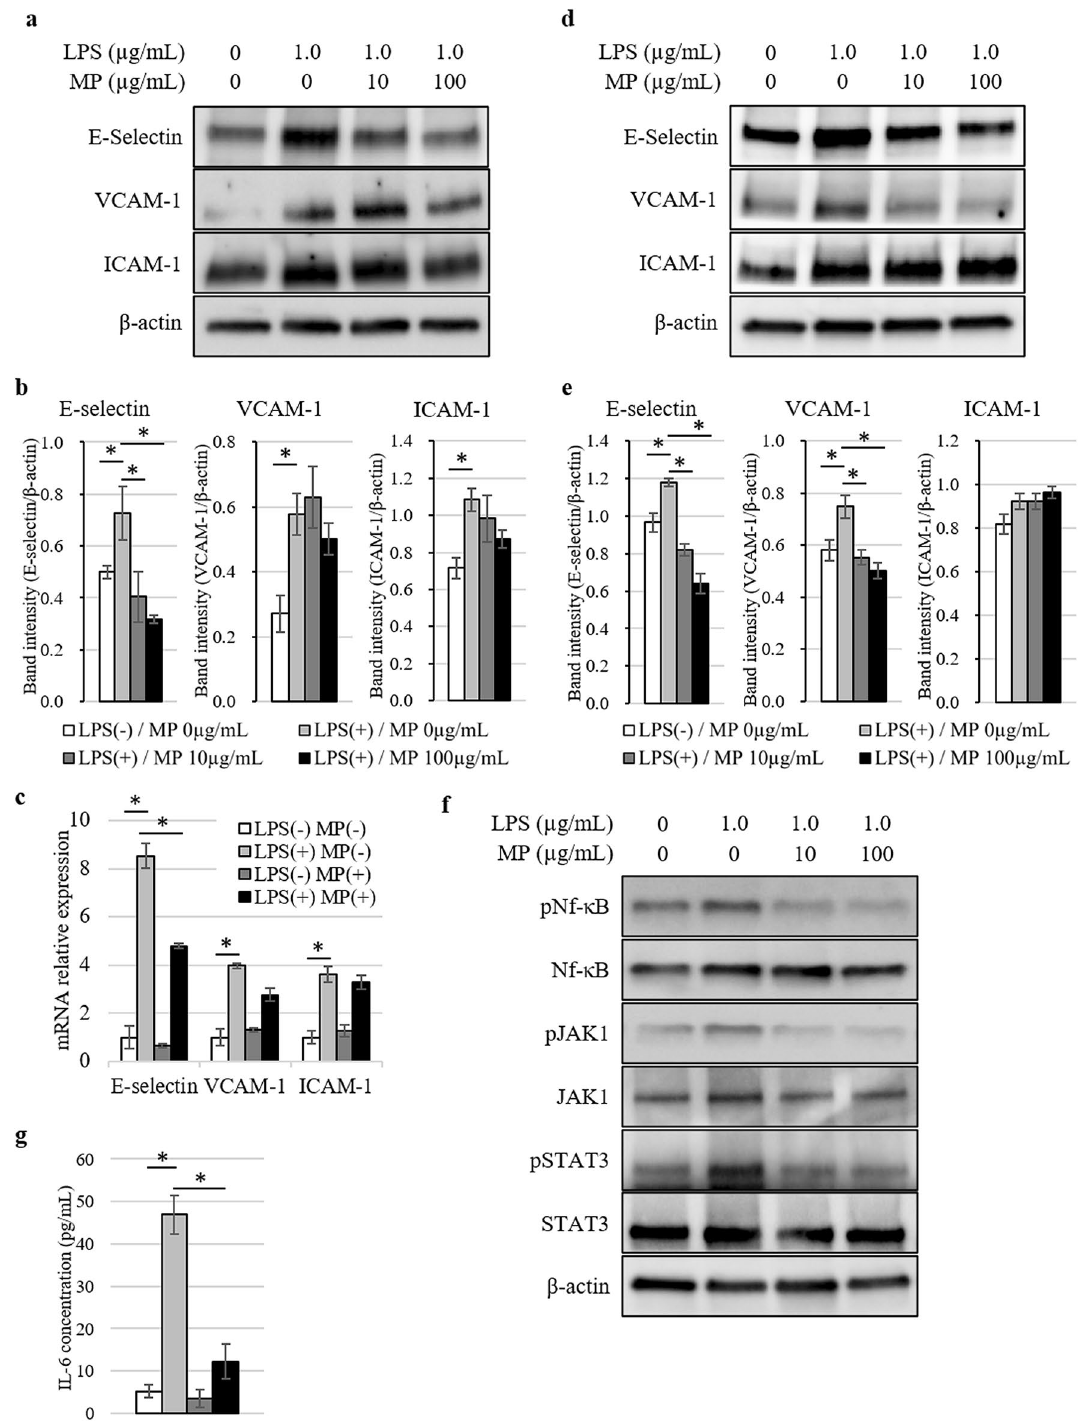
Figure 1. Analysis of adhesion molecules expressed in vascular endothelial cells stimulated by LPS and MP. ( a ) Protein expression levels of E-selectin, VCAM-1, and ICAM-1 in HUVEC at 6 h after stimulation analyzed by western blotting. Blot was cut horizontally and immunoblotting was performed for each section. ( b ) Quantification of E-selectin, VCAM-1, and ICAM-1 band intensity normalized to β-actin in HUVEC. Data are means ± standard error (n = 3, each group); * P < 0.05. ( c ) Induction of SELE , VCAM1 , and ICAM1 gene expression in HUVEC 6 h after stimulated by 1.0 µg/mL of LPS and 100 µg/mL of MP was analyzed by quantitative real-time PCR. Data are normalized relative to ACTB mRNA levels. Data are means ± standard error (n = 3, each group); * P < 0.05. ( d ) Protein expression levels of E-selectin, VCAM-1, and ICAM-1 in HHSEC at 6 h after stimulation analyzed by western blotting. Blot was cut horizontally and immunoblotting was performed for each section. ( e ) Quantification of E-selectin, VCAM-1, and ICAM-1 band intensity normalized to β-actin in HHSEC. Data are means ± standard error (n = 3, each group); * P < 0.05. ( f ) The phosphorylation of Nf-κB, JAK1, and STAT3 was analyzed by western blotting with antibodies targeting pNf-κB/Nf-κB, pJAK1/JAK1, and pSTAT3/STAT3 at 30 min after the stimulation. Blot was cut horizontally and immunoblotting was performed for each section. ( g ) ELISA analysis of IL-6 concentration levels in conditioned medium 6 h after stimulated by 1.0 µg/mL of LPS and 100 µg/mL of MP. Data are means ± standard error (n = 3, each group); * P <